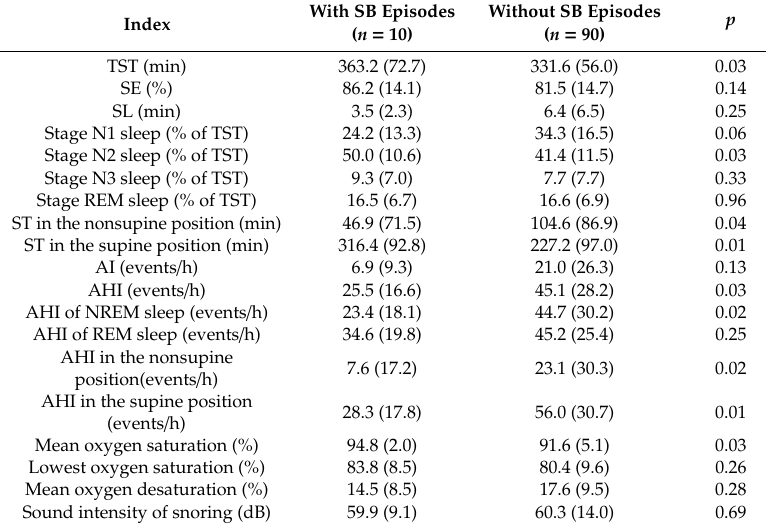
Table 2. Univariate statistical analysis of polysomnographic indices in 100 patients with OSAS with and without SB episodes.